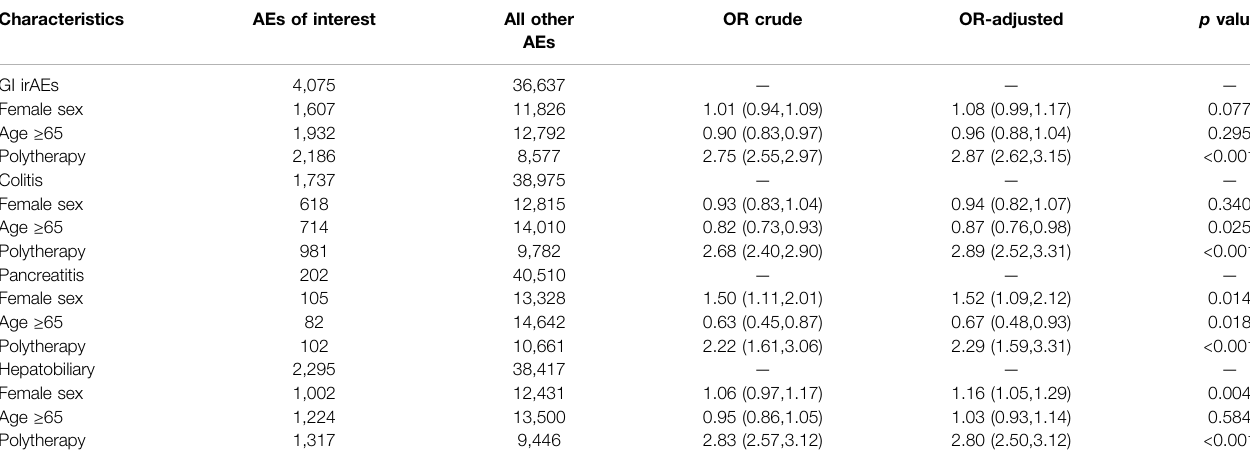
TABLE 3 | Multivariate logistic analysis of patients with common GI irAEs.